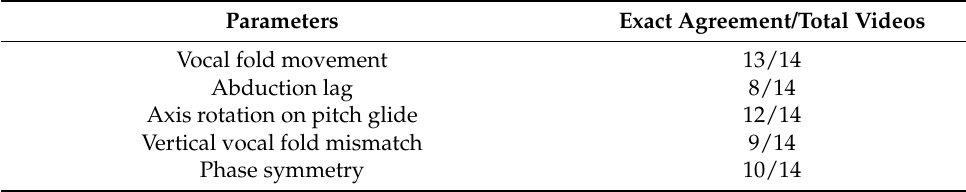
Table 4. Inter-rater reliability of strobolaryngoscopy